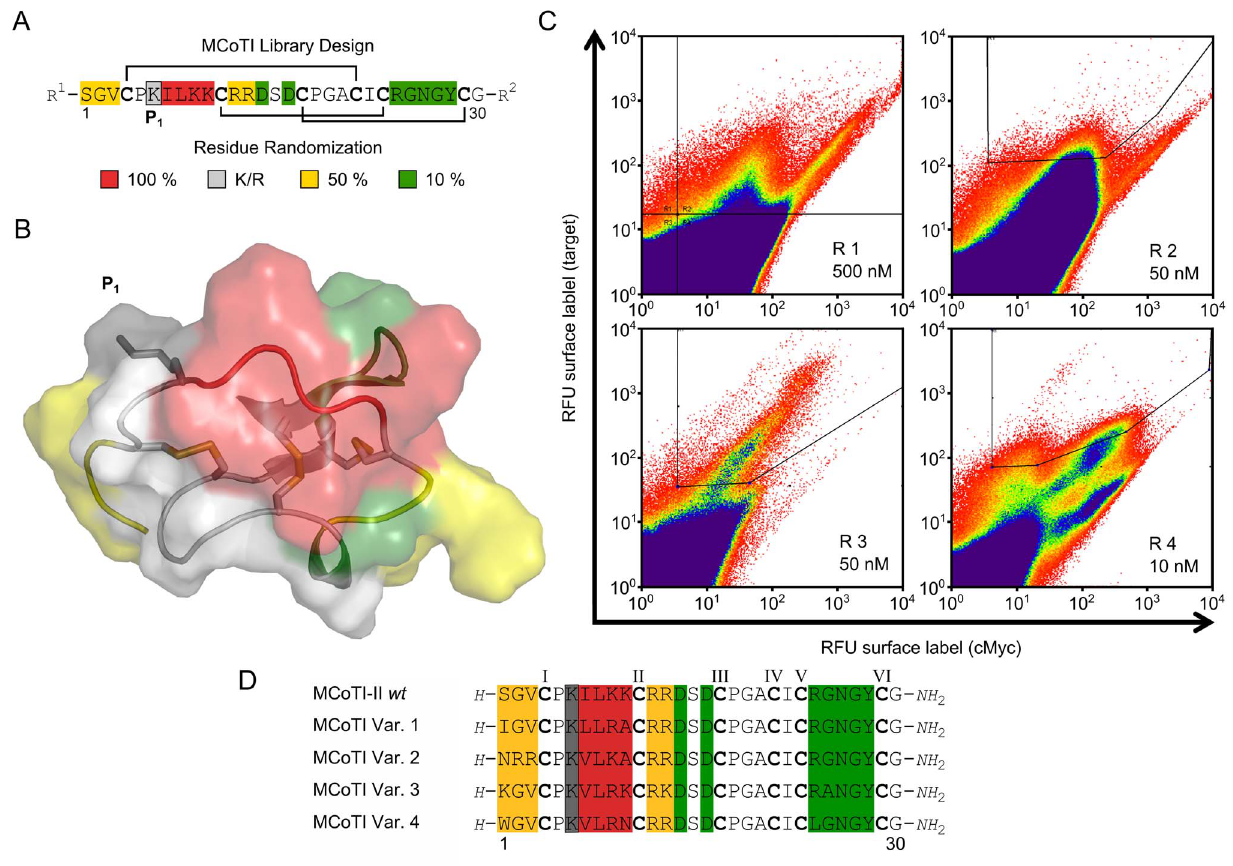
Figure 3. Summary of MCoTI-II-based library design and screening against matriptase-1. ( A ) Sequence of open-chain MCoTI-II wild type . Cysteines are depicted in bold letters. R 1 represents the amino-terminal flanking sequence, including the HA-epitope. R 2 represents the carboxy- terminal flanking sequence, including the cMyc-epitope. Codon randomization for ( A ), ( B ), and ( D ) as indicated by color (at pos. 6 only Lys or Arg was allowed, grey). ( B ) Secondary structure of MCoTI-II is shown as cartoon with surface, cysteine residues are shown as orange sticks. ( C ) FACS histograms showing four rounds of sorting with decreasing target concentration for enrichment of matriptase-1 binders. R denotes the sort round with the concentration of matriptase-1 indicated. Actual sort gates are shown. ( D ) Sequence alignment of matriptase-1-binding MCoTI variants. Cysteines are numbered according to the appearance in the sequence and depicted in bold letters, while cystine connections are omitted for clarity.